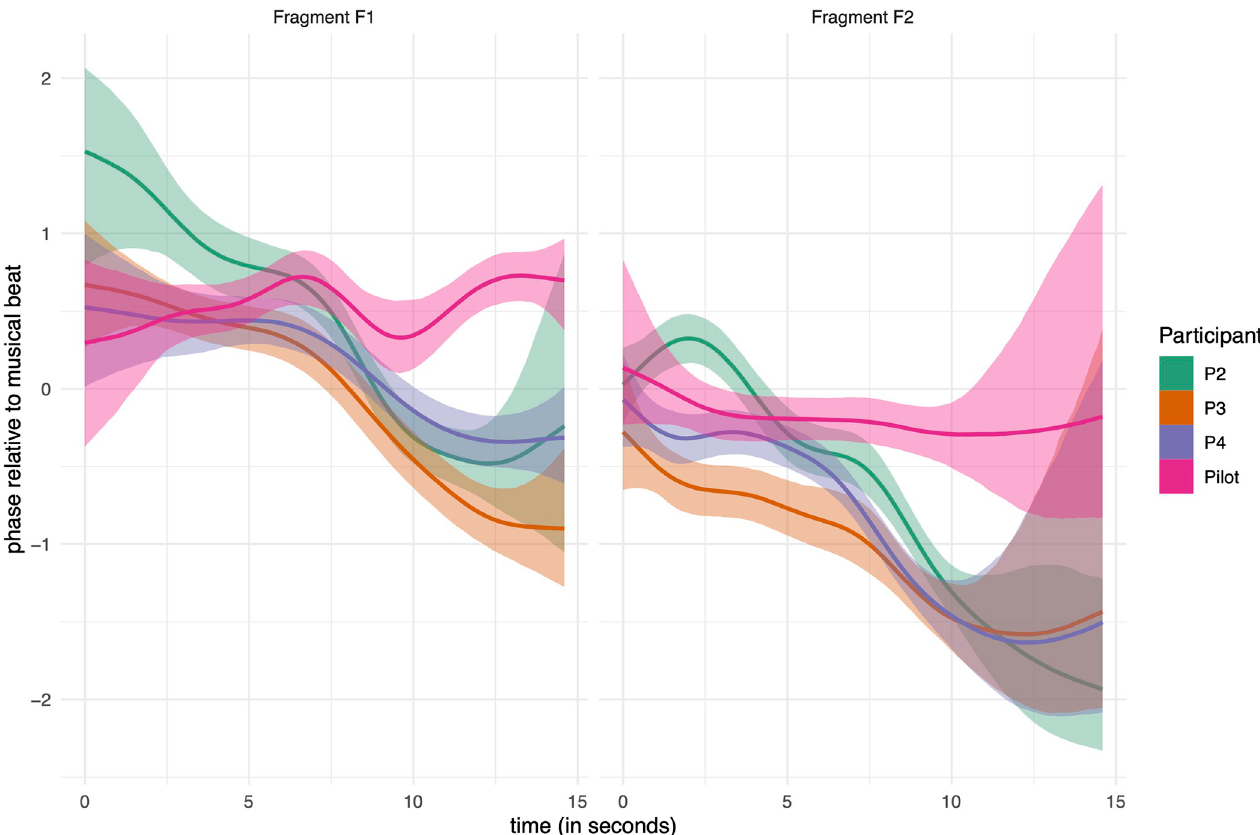
Fig 7. Results of model H3b. Dynamical means (full lines) and 95% critical intervals (bands) of posterior predictions of Heel Down. Horizontal axis is performance time, vertical axis is phase (in radians).